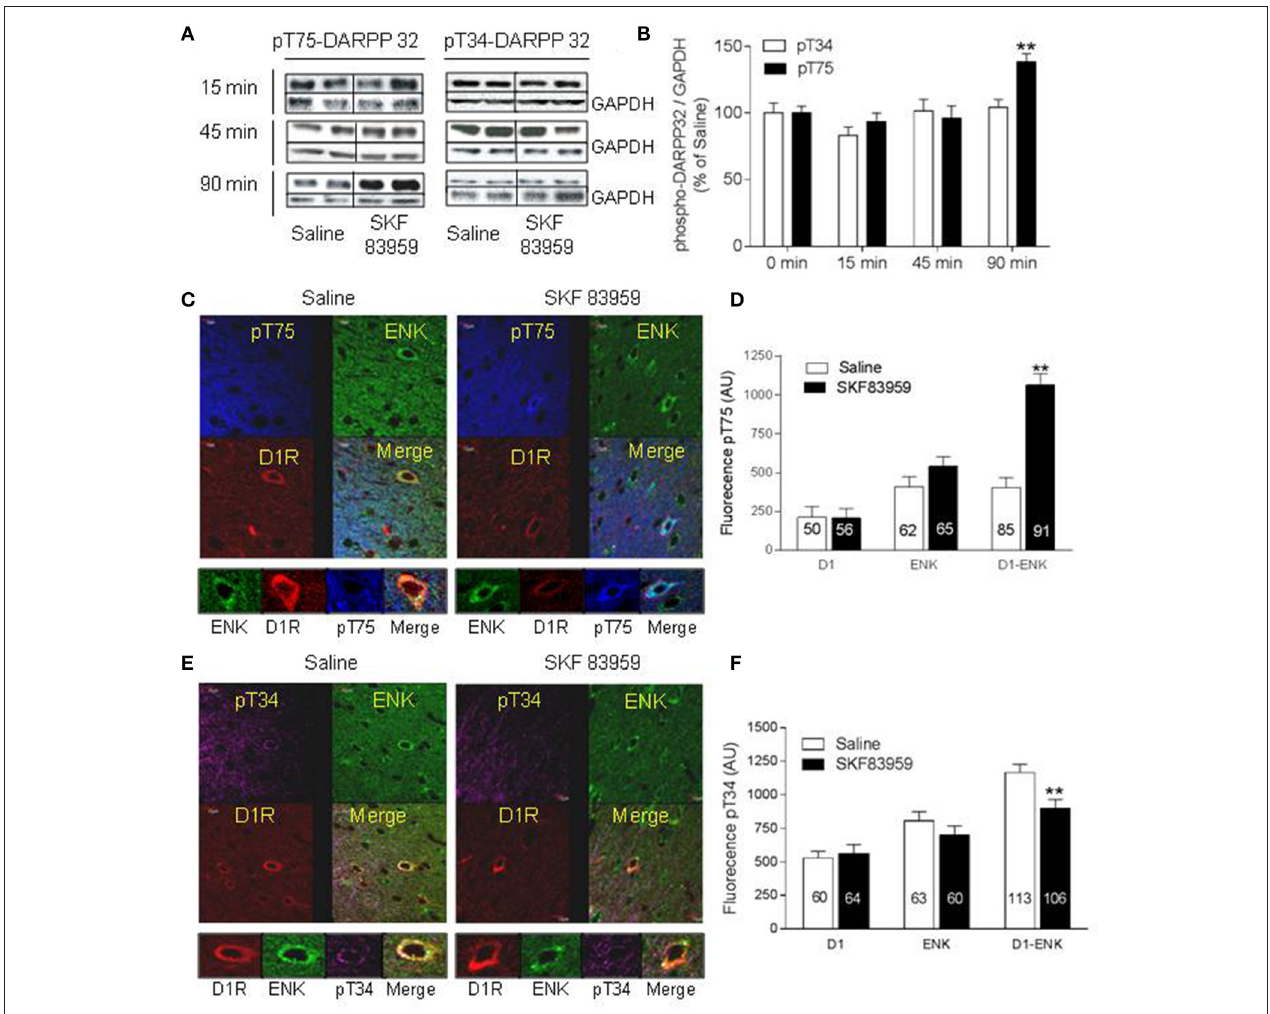
FIGURE 3 | Activation of Thr75-DARRP-32 by D1-D2 heteromer in rat NAc. (A,B) Rats ( n = 8/group) were injected with saline or SKF 83959 (1.5 mg/kg, s.c.), sacrificed 15, 45, or 90min later, and phospho-Thr34-DARPP-32 (pT34) or phospho-Thr75-DARPP-32 (pT75) analyzed by western blot with GAPDH as loading control. (A) Representative blots of pT34 and pT75. (B) Quantification of blots from all animals represented as % mean ± SEM of control (saline values), (** p < 0.05). (C–F) Rats were injected with saline or SKF 83959 (1.5 mg/kg), sacrificed 15min later, and immunohistochemistry performed using anti-pT34 or anti-pT75 assessed in the three types of MSNs: D1R-only (red arrow), Enk-only (D2R, green arrow) or D1R and ENK (D1-D2 heteromer)-expressing neurons (yellow arrow). (C) Representative confocal images of pT75-DARPP-32. (D) Quantification of pT75-DARPP-32 fluorescence in MSNs ( n = numbers of neurons from at least N = 3 rats/condition). (E) Representative confocal images of pT34-DARPP-32. (F) Quantification of pT34 fluorescence in MSNs. Data represents means ± SEM after removal of non-specific background. (** p <